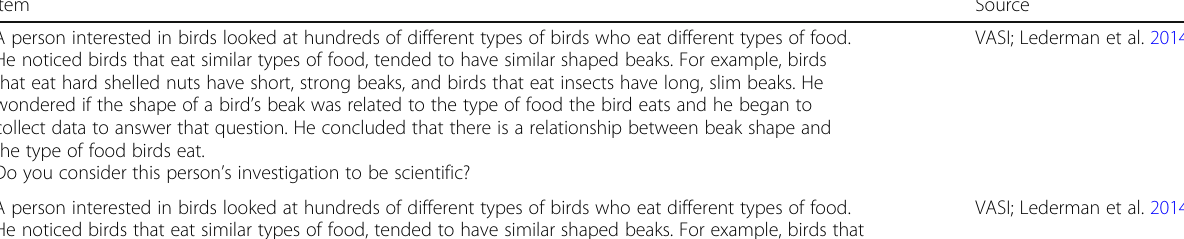
Table 1 Nature of Science items included in this study Item